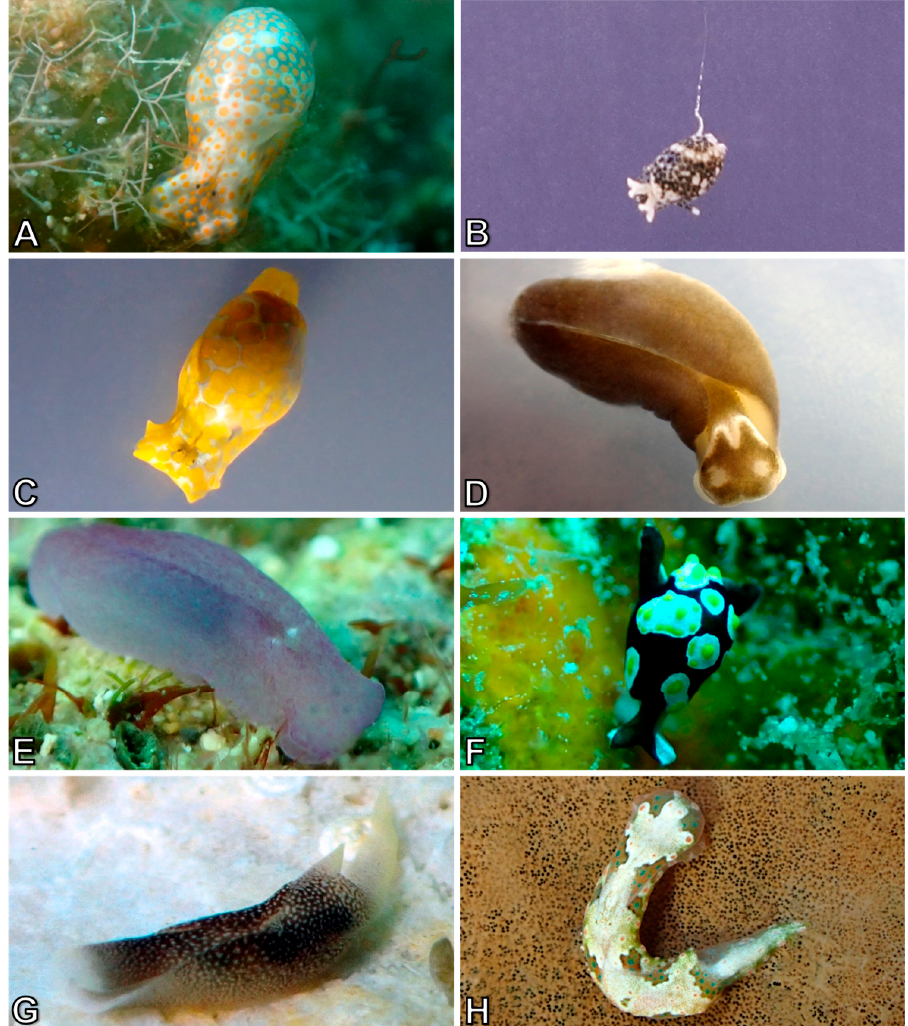
Figure 2. Cephalaspidea: ( A ) Haminoea spec. ( Haminoea sp. 2 in Gosliner et al. [11]: 30), Hasp16Bu-1; ( B ) Haminoea spec. ( Haminoeid sp. 2 in Gosliner et al. [11]: 34), Hasp3_16Bu-1; ( C ) Haminoea spec., Hasp2_16Bu-1; ( D ) Phanerophthalmus albocollaris ; ( E ) Phanerophthalmus spec. ( Phanerophthalmus sp. 3 in Gosliner et al. [11]: 33), Phsp3_16Bu-1; ( F ) Colpodaspis thompsoni ; ( G ) Chelidonura amoena ; ( H ) Odontoglaja guamensis.